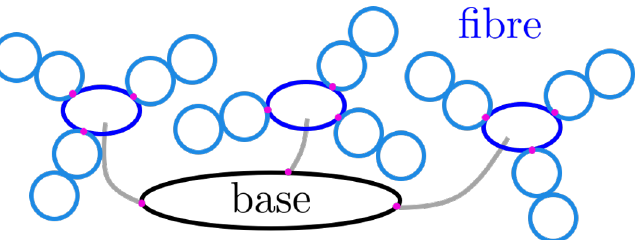
Figure 3 . Depiction of the resolution of the orbifold singularities in ( T 2 × T 2 ) / Z 3 . Light blue circles depict the Z resolution divisors. The ambient tori over fiber and base also become P 1 ’s 3 depicted as blue and black